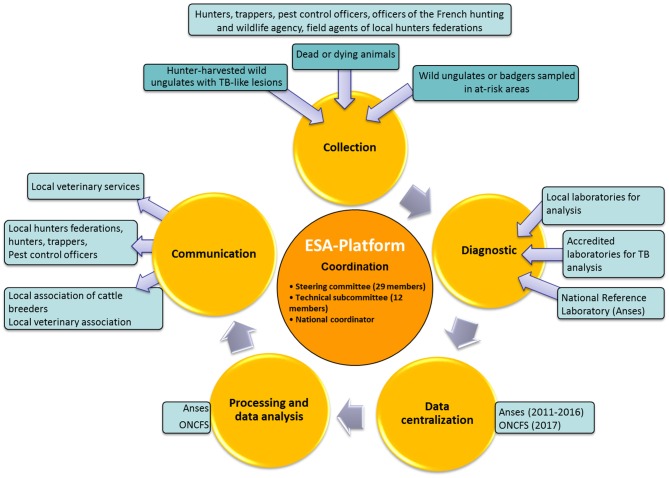
Simplified organization of Sylvatub. Steering committee members: French General Directorate for Food (DGAL), Ministry of the Environment (MEDDE), Regional Directorates for Food (DRAAF), Anses, French hunting and wildlife agency (ONCFS), National Hunters Federation (FNC), French association of pest control officers, French association of approved trappers, the French National Federation of Animal Health Defense Associations (GDS France), National veterinary association (SNGTV), Coop de France and French Association of Directors and Managers of Public Veterinary Laboratories of Analyzes (Adilva), Regional veterinary epidemiologists. Technical subcommittee members: DGAL, Anses, ONCFS, DRAAF, FNC, GDS France, Adilva.